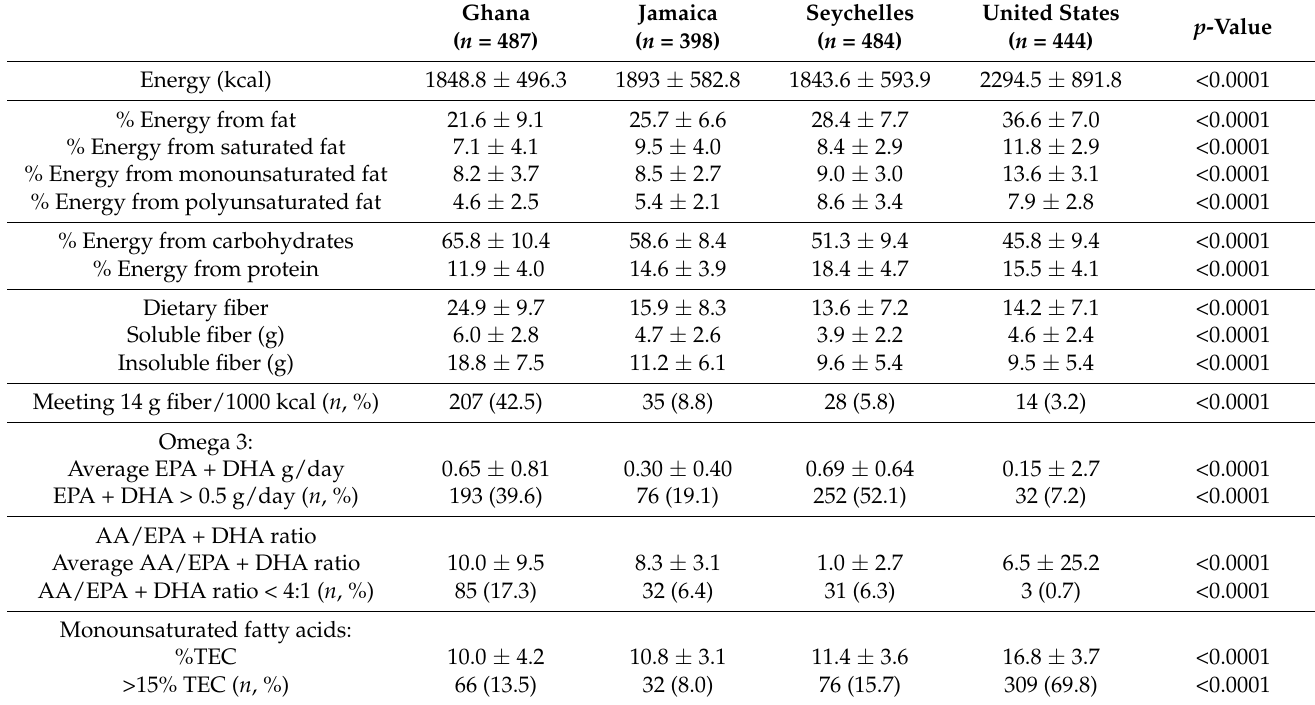
Table 2. Dietary analysis of study population by site.